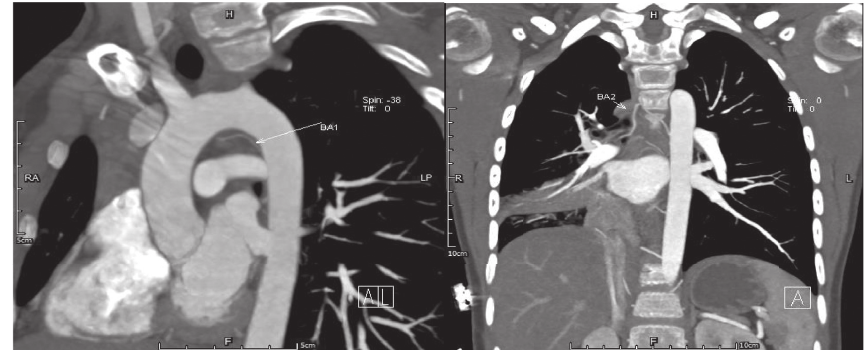
Figure 2: CTA demonstrated that BA1 originated from the thoracic aorta to the left at the level of the upper margin of T5 and entered the right hilum above the bifurcation of the trachea. BA2 arose from the right side of the thoracic aorta at T6 and passed up to the right and then down to the right hilum, with a widening of the diameter (2mm) of the primary and middle tubes.